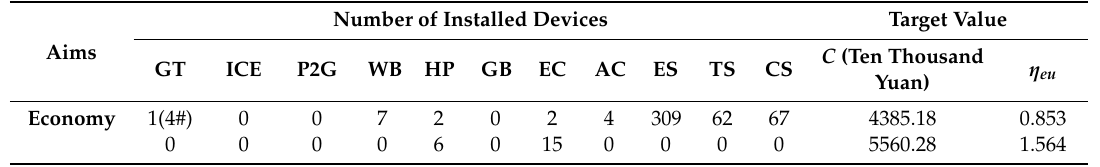
Table 1. Number of installed devices under different objective functions.